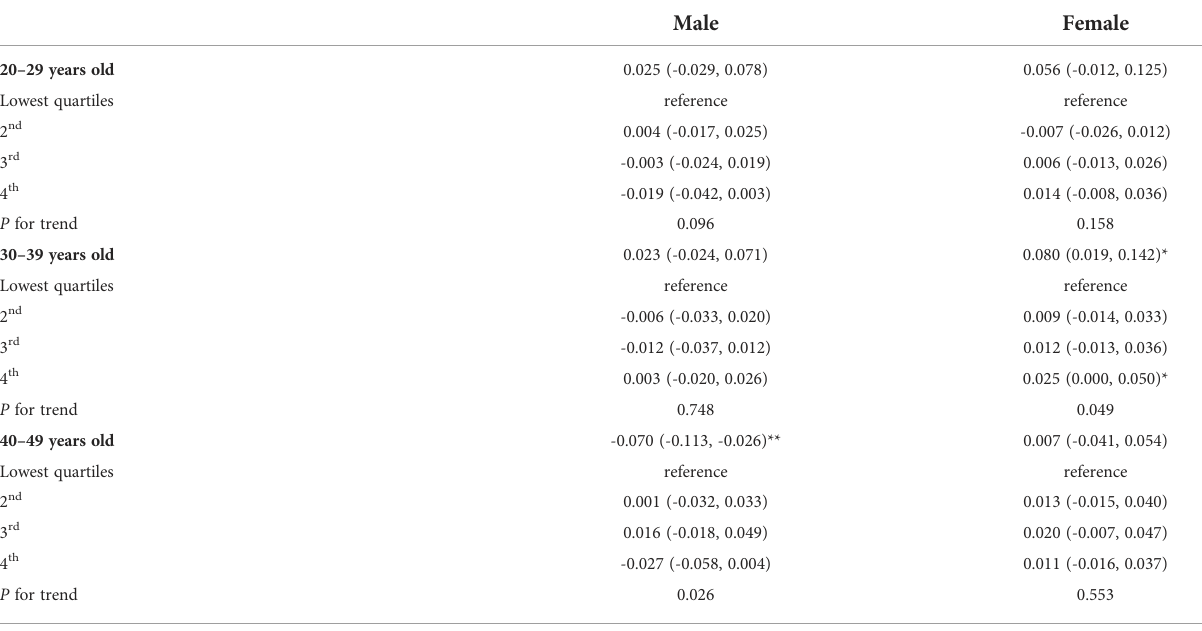
TABLE 3 Association between Average caffeine intake (g/day) and lumbar bone mineral density (g/cm 2 ), strati fi ed by age and gender. Quintiles of average caffeine intake